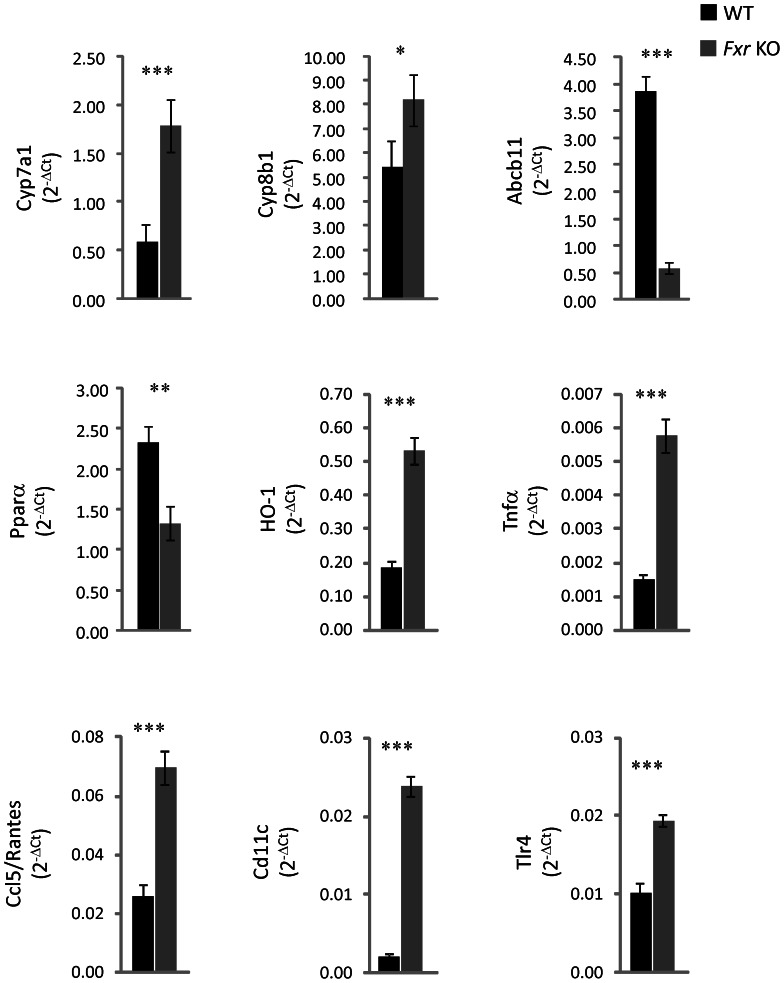
Liver gene expression levels.RNA expression levels in WT (n = 8, black bars) and Fxr KO mice (n = 8, grey bars). Statistical analysis was performed using Student's T-test. * p<0.05, ** p<0.01, *** p<0.001 Fxr KO vs. WT mice.